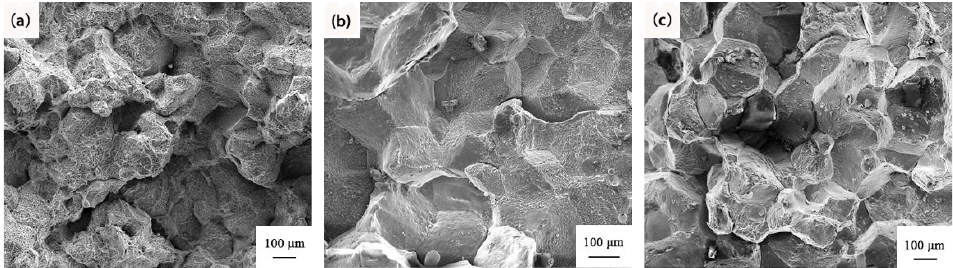
Figure 3. Fracture morphology of different samples tested at 750 °C for ( a ) steel 1; ( b ) steel 2; and ( c ) steel 3.